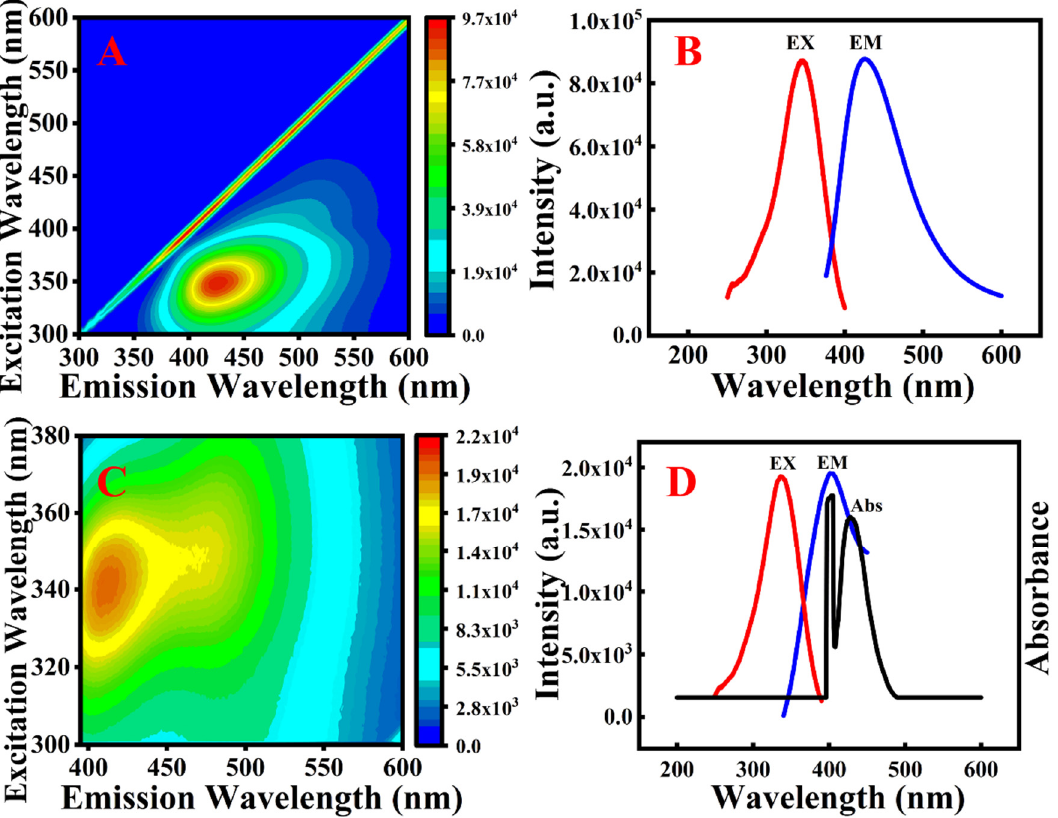
Figure 4. ( A ) Excitation–emission matrix of the N-CQDs. ( B ) Fluorescence excitation and emission